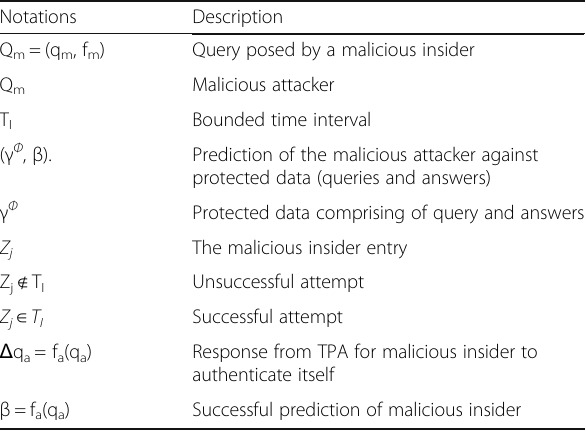
Table 2 System Parameters and Definitions for malicious insider and